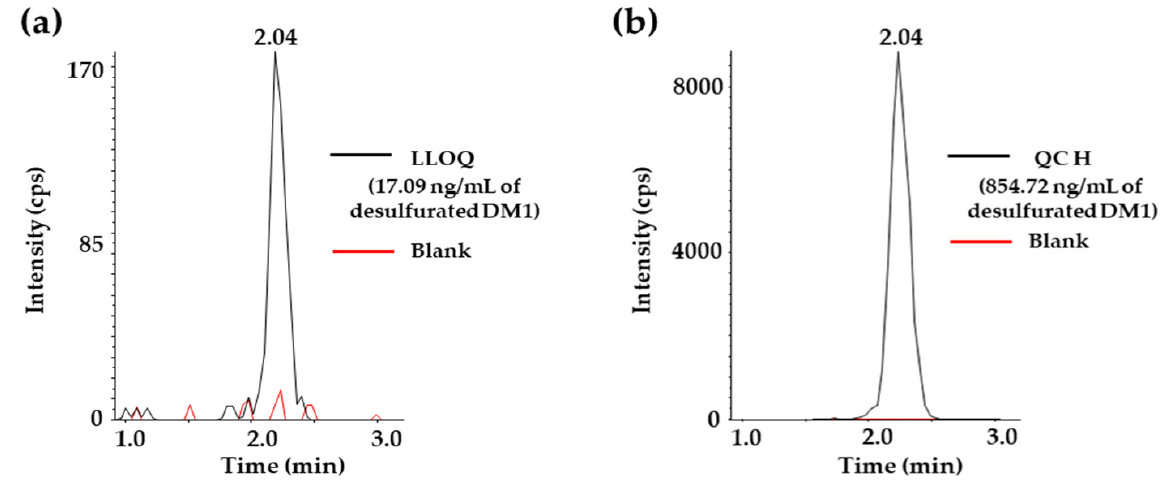
Figure 4. Representative chromatograms of ( a ) limit of quantification (LLOQ, 17.09 ng/mL) and ( b ) high level quality control (QC H, 854.72 ng/mL) of desulfurated DM1. Table 2. The intra/inter-run assays for QC samples of desulfurated DM1. Intra-Run Assay Run